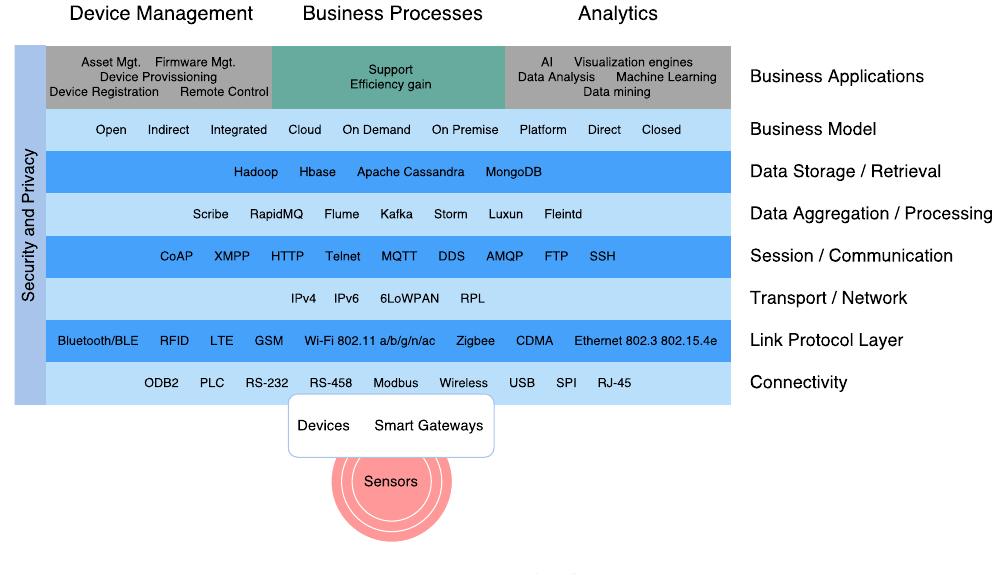
Figure 10. IoT landscape.